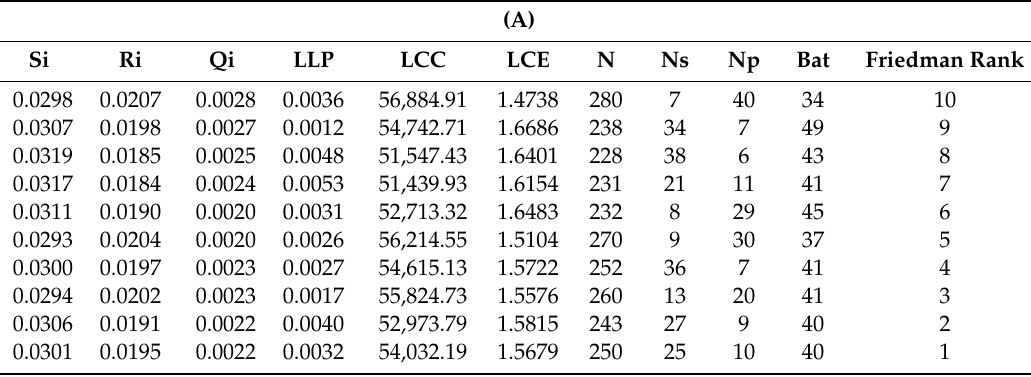
Table 8. ( A ) Results of the AHP-VIKOR method of the SAPV system based on the lead–acid battery for the first evaluator. ( B ) Results of the AHP-VIKOR method of the SAPV system based on the lead–acid battery for the second evaluator. ( C ) Results of the AHP-VIKOR method of the SAPV system based on the lead–acid battery for the third